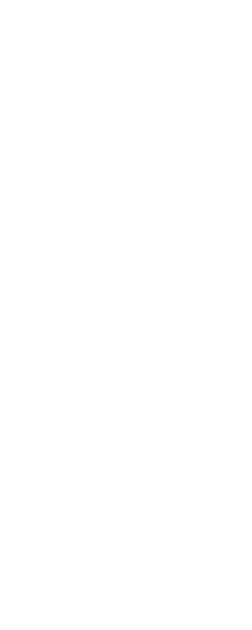
Table 3. Explanation of the assessment and list of the general requirements. List of the Main Requirements for